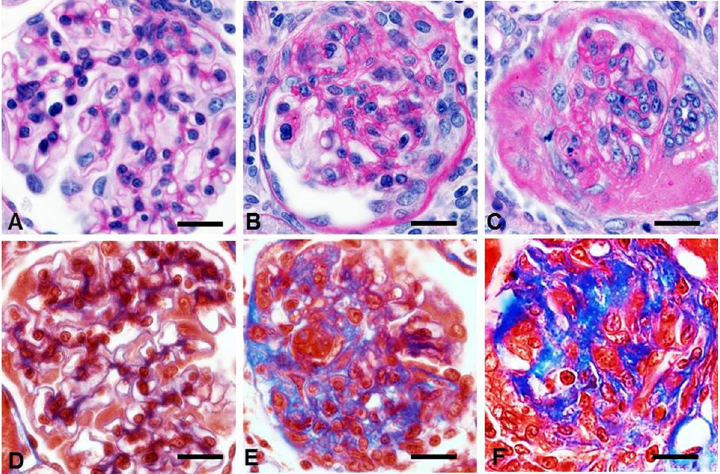
Fig 5. Hypertensive glomerulopathy in the clipped kidney resembled human glomerulosclerosis. A, D Control rats. B, C, E, F Tufts showed features of the ischemic glomeruli , including reduced capillary lumens, retracted tufts, narrowed Bowman’s spaces, PAS filled mesangium with small collagen amount. A-C— periodic acid-Schiff; D-F — Masson trichrome staining. x600.